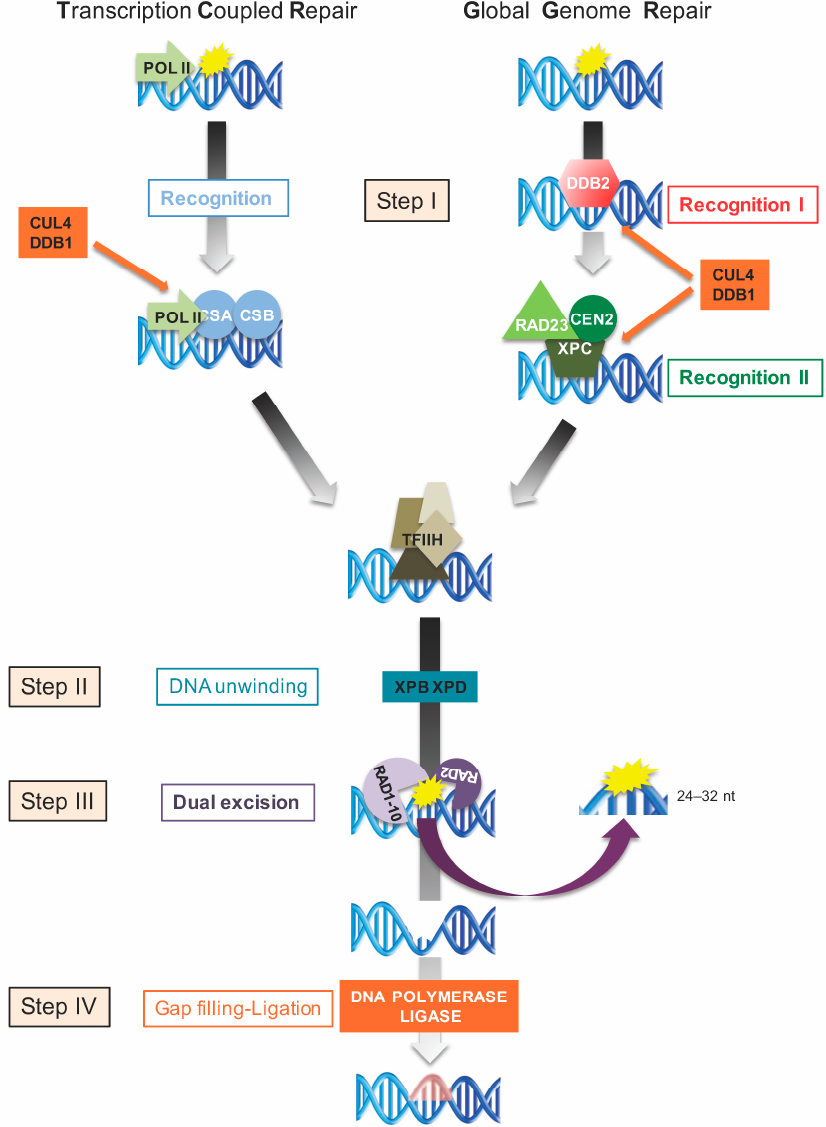
Figure 2. Nucleotide excision repair (NER) pathways. Schematic representation of the four main steps of the two NER subpathways: transcription-coupled repair (TCR) and global genome repair (GGR). The recognition of photolesions (Step I) is performed by TCR and GGR specific factors. One recognition complex acts during TCR, whereas two recognition complexes are necessary for GGR. Subsequently, for both TCR and GGR, DNA helicases open the chromatin (Step II), allowing the excision of the damaged DNA strand (Step III) and its synthesis-dependent repair (Step IV). Yellow star: photolesions. Newly synthetized DNA is shown in red.